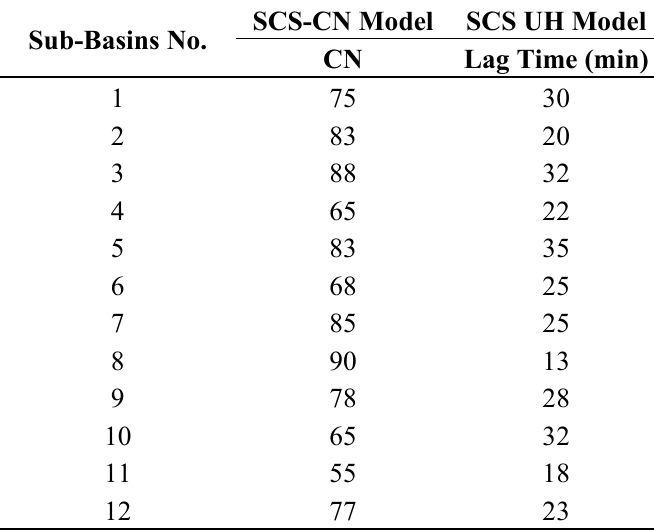
Table 6. The Calibration Result of the Run-off Volume and the Direct-runoff, Scheme II.